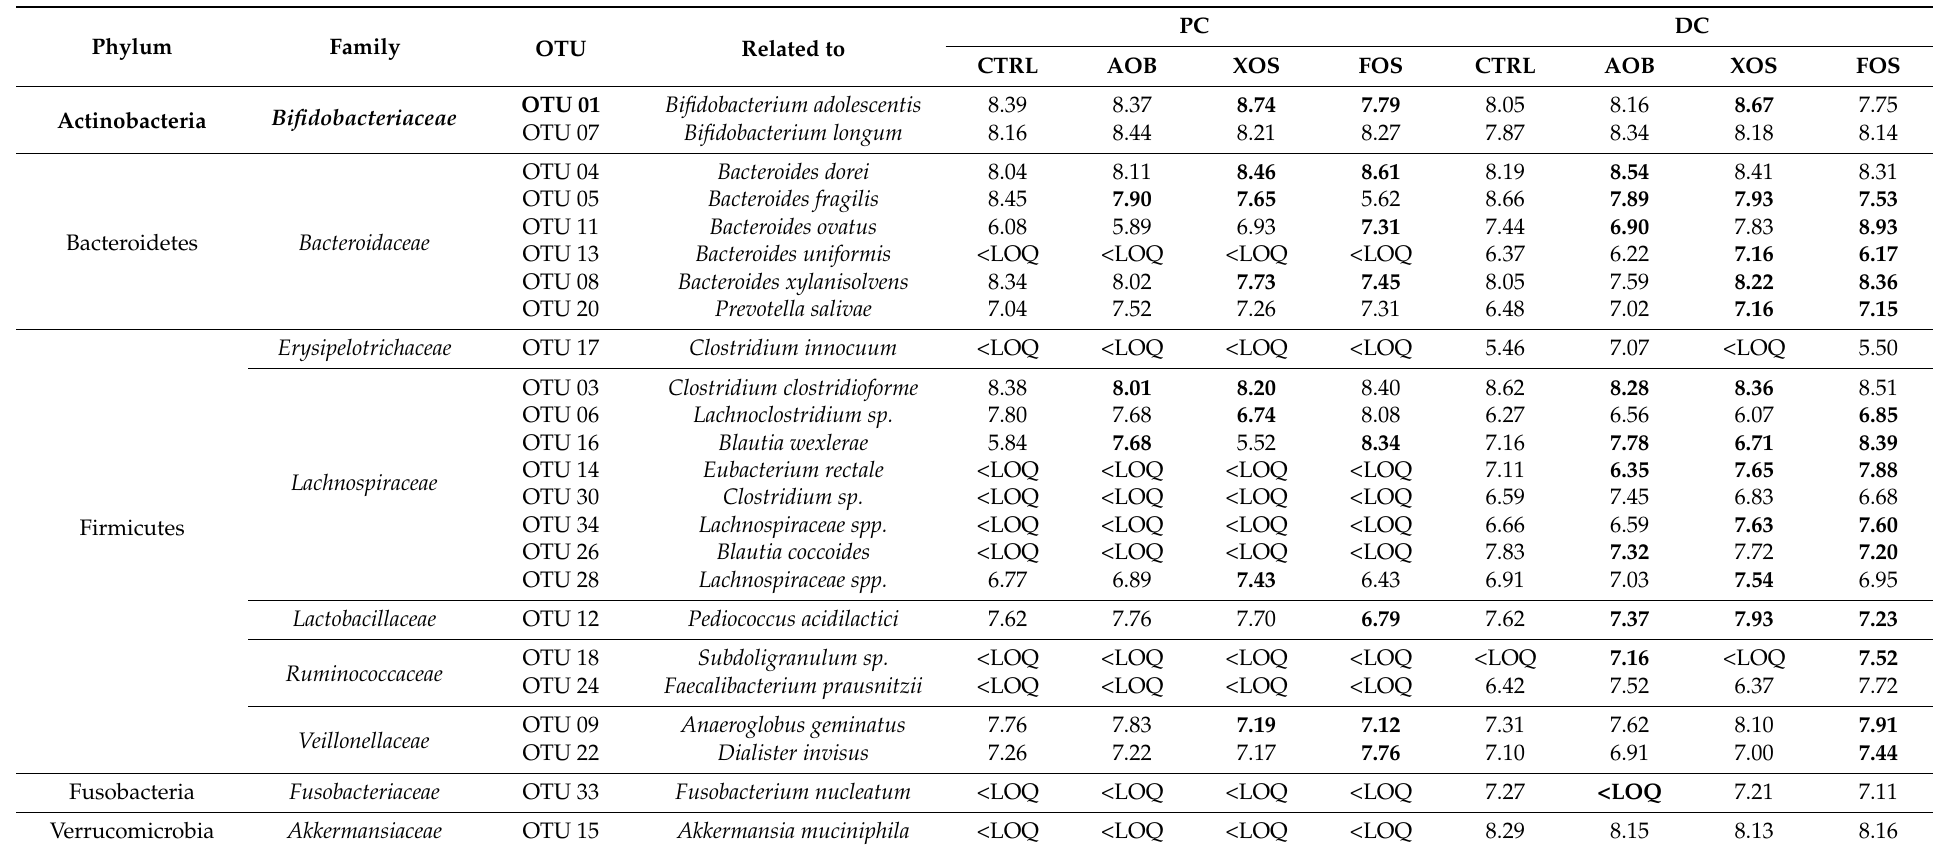
Table 2. Average microbial abundances of the 30 most abundant OTUs (log(cells/mL)) as detected via quantitative 16S rRNA gene-targeted Illumina sequencing of AOB, XOS and FOS versus a blank control during 2 weeks of treatment ( n = 4) for donor 2. Statistically significant differences between the control and treatments are indicated in bold ( p < 0.05). PC = proximal colon; DC = distal colon; CTRL = control; AOB = antioxidant blend; XOS = xylooligosaccharides; FOS =